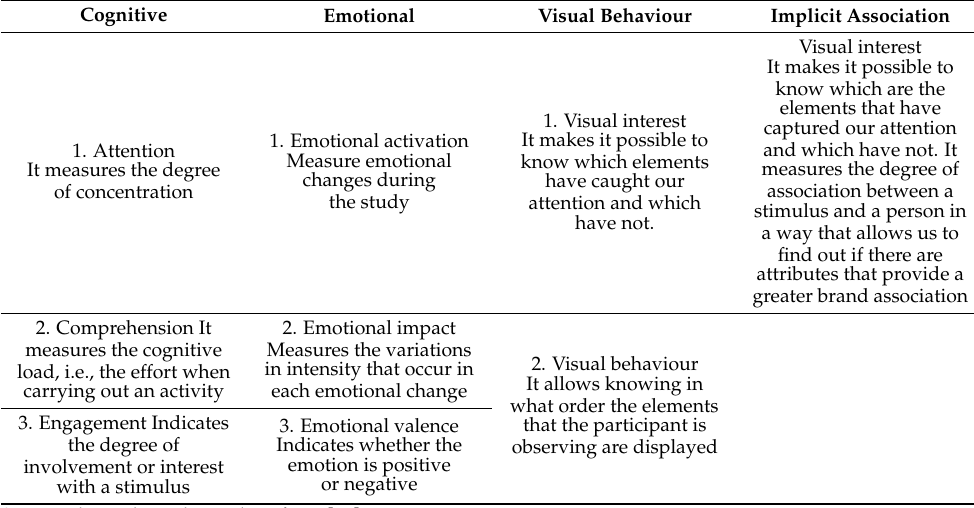
Table 2. Variables and metrics in